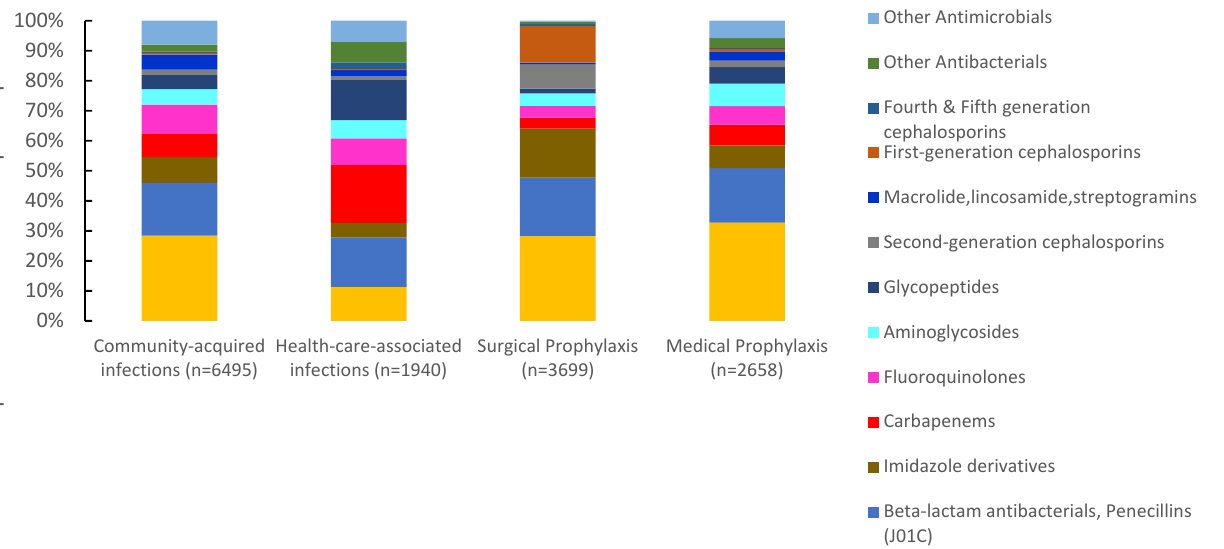
Figure 3. Distribution of prescribed antimicrobials according to clinical indications, seven countries in Eastern Mediterranean Region *, 2019. * Seven countries are Tunisia, United Arab Emirates, Lebanon, Jordan, Pakistan, Sudan, and Iraq. $ Other antimicrobials include systemic antivirals, antiprotozoals, intestinal anti-infectives, antimycotics. for systemic use and antimycobacterial. (n = number of prescriptions).